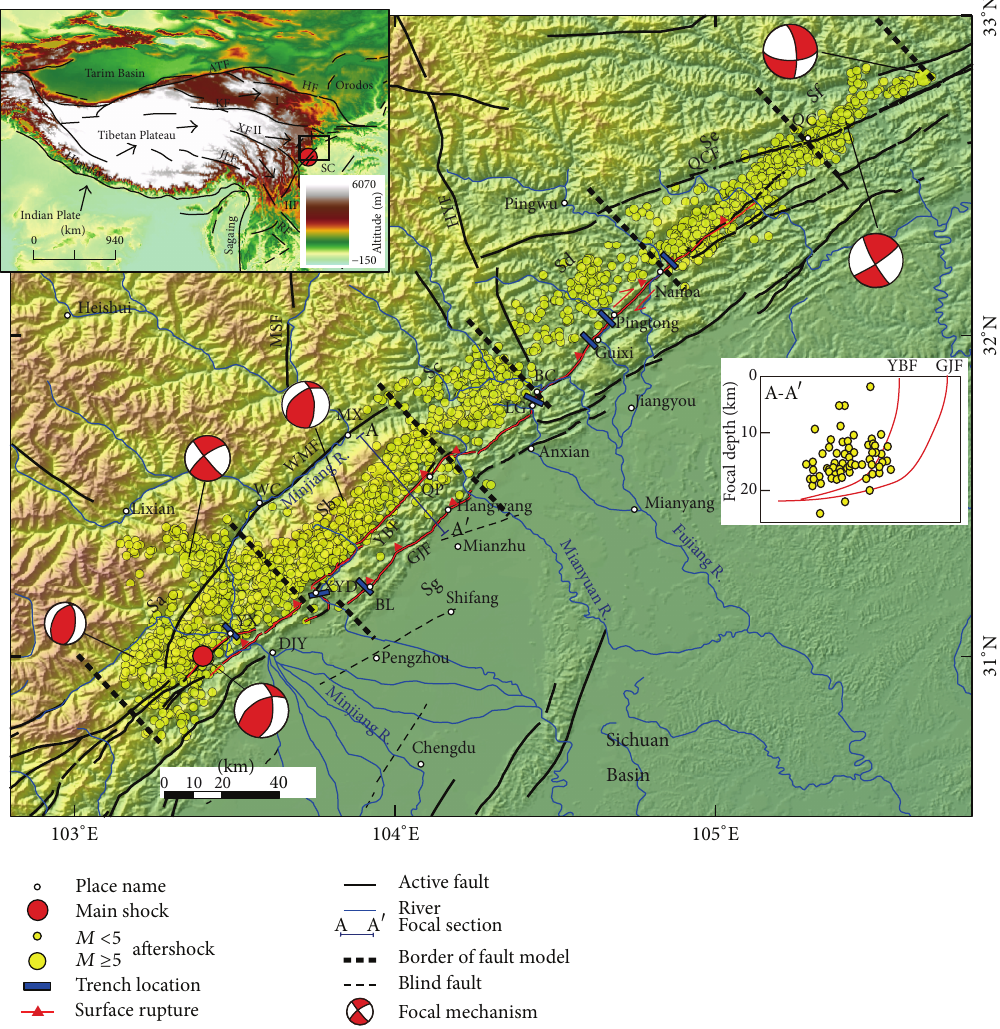
Figure 1: Tectonic settings and aftershock sequence of the 2008 Wenchuan earthquake. Surface rupture is modified from [4]; focal mechanisms are from USGS; aftershock sequence is from relocated results [28]. Borders of fault model are according to GPS and InSAR inversion [6]. Trench sites are from published results [12–14]. White circles are place names: BC, Beichuan county; BL, Bailu town; DJY, Dujiangyan city, LG, Leigu town; MX, Maoxian county; QC, Qingchuan county; QP, Qingping town; WC, Wenchuan county; XYD, Xiaoyudong town; YX, Yingxiu town. Black solid lines are known faults: YBF, Yingxiu-Beichuan fault; GJF, Guanxian-Jiangyou fault; WMF, Wenchuan-Maoxian fault; QCF, Qingchuan fault; MSF, Minshan fault; HYF, Huya fault. Insert map shows the topography of the Tibetan plateau. Inset map shows major tectonics in the Longmen Shan vicinity: ATF, Altyn Tagh fault; HF, Haiyuan fault; JLF, Jiali fault; KF, Kunlun fault; RF, Red River fault; XF, Xiaoshuihe fault; I, Qaidam-Qilian block; II, Bayan Har block; III, Sichuan-Yunan block. Black arrows indicate block motion